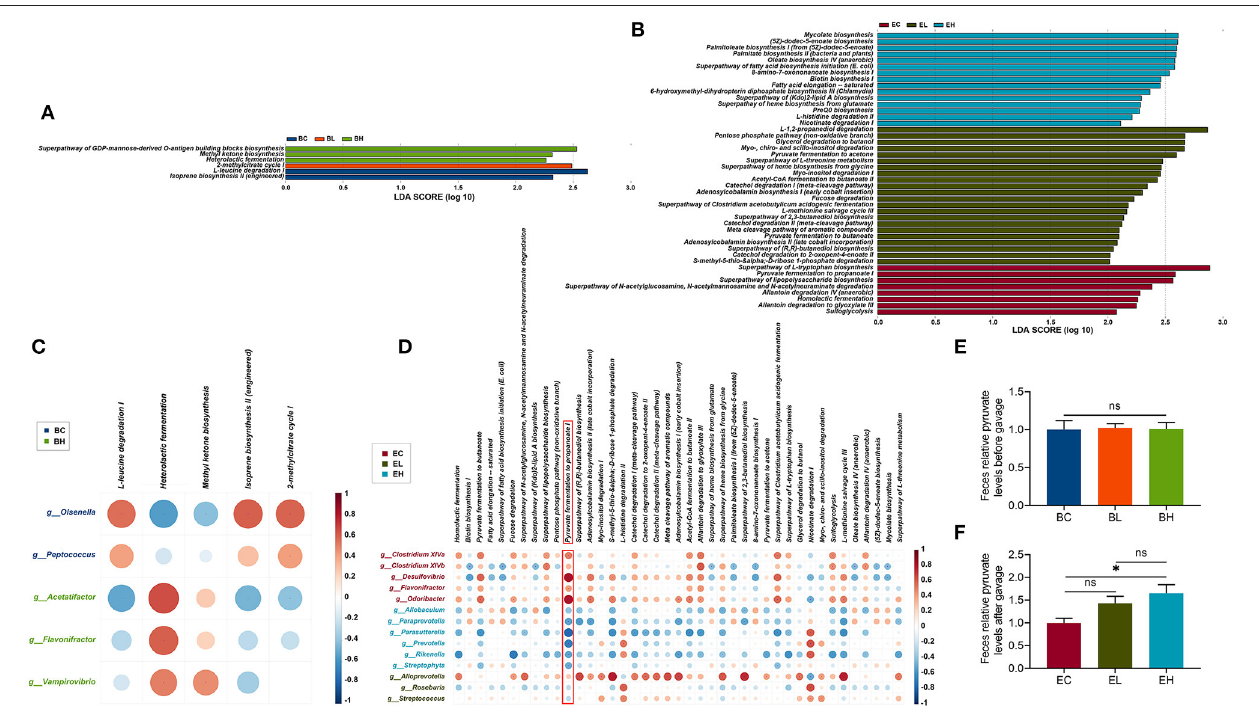
FIGURE 6 | Chronic high dose of leucine supplementation suppressed pyruvate fermentation to propanoate I in feces. (A,B) Based on the MetaCyc metabolic pathways database, 6 and 45 differential metabolic pathways clustered in the baseline and endpoint groups (LDA > 2); (C,D) correlation networks between differential species at genus level and differential metabolic pathways; differential species seemed to more closely related to pyruvate fermentation to propanoate I in the endpoint groups among all the metabolic pathways. (E) The pyruvate levels in feces of the baseline groups; (F) the pyruvate levels in feces of endpoint groups; ns, no significance; * P <